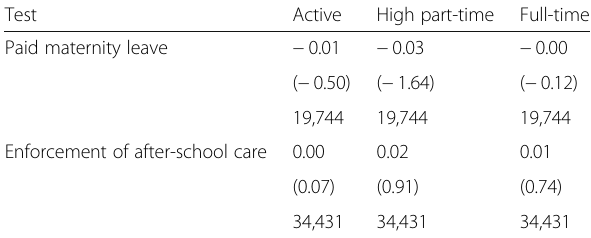
Table 7 Difference-in-differences estimates of the impact of